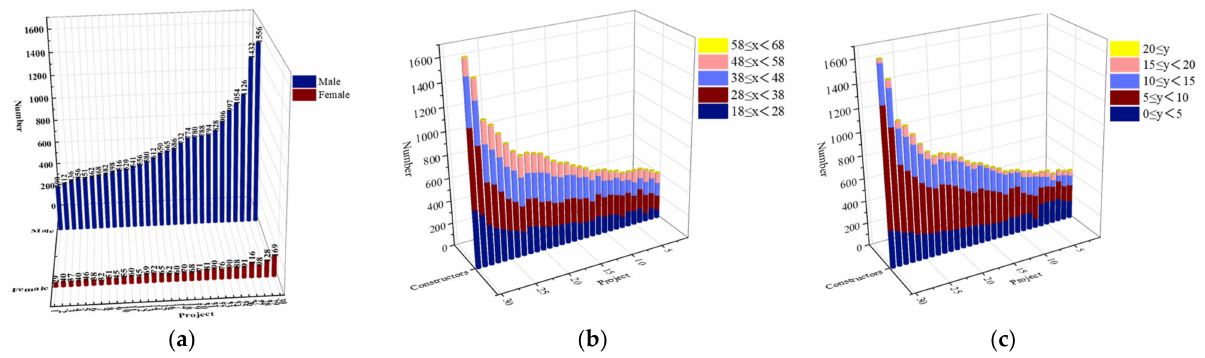
Figure 3. Results of survey research from 30 FTBCS in China. ( a ) Gender of constructors; ( b ) age composition of constructors; ( c ) occupational age of